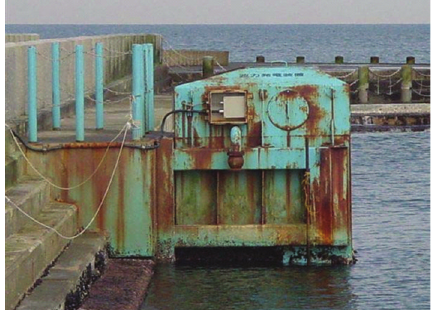
Figure 15: OWC device at Niigata-Nishi Port,